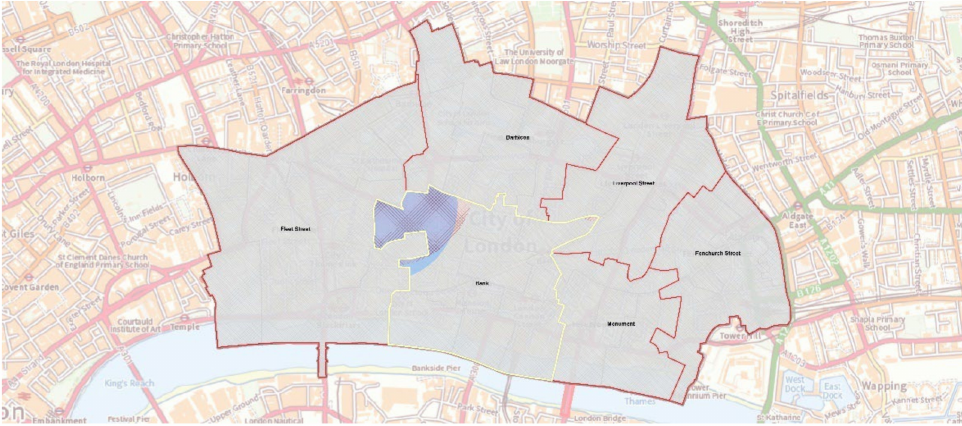
Figure 7. Drug crime hot spots in the Bank cluster for the years 2020 (marked in blue) and 2021 (marked in